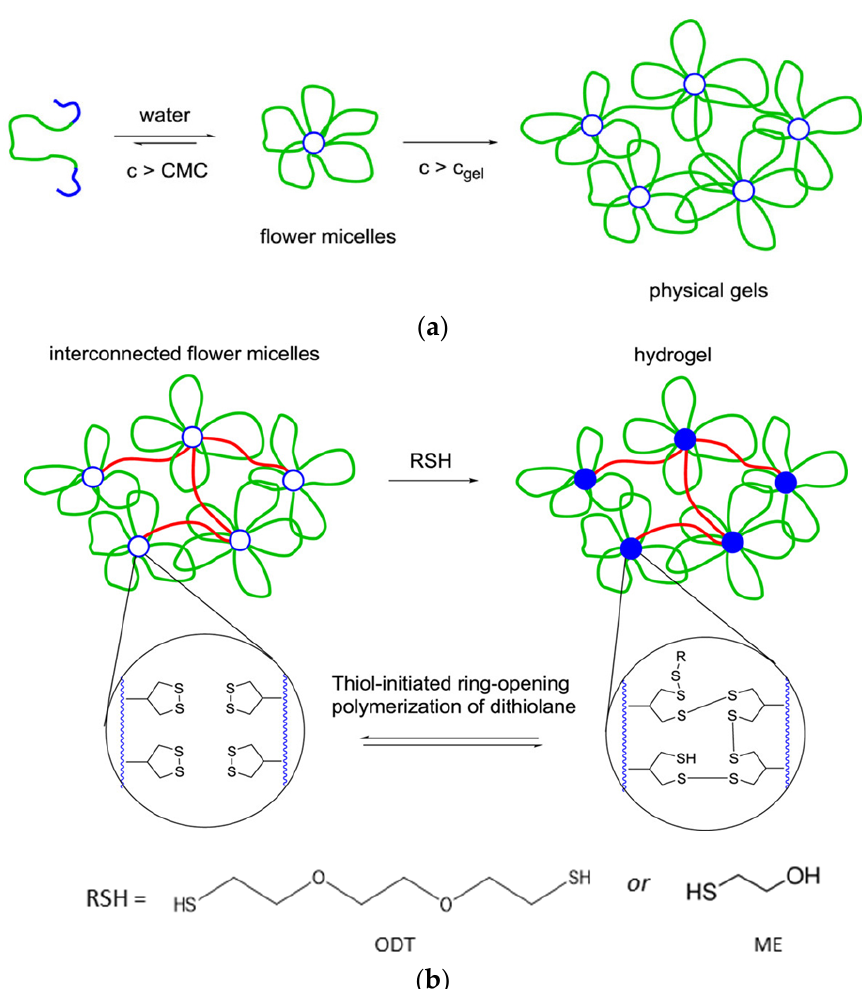
Figure 29. ( a ) ABA triblock copolymers, like DBCP, with hydrophobic end blocks and their self- assembly into flower micelles above their critical micelle concentrations and gelation at still higher concentrations. ( b ) Formation of chemically crosslinked gels from DBCPs after addition of dithiol 3,6-dioxa-1,8-octadecanethiol. Adapted with permission from [31]. Copyright (2017) American Chemical